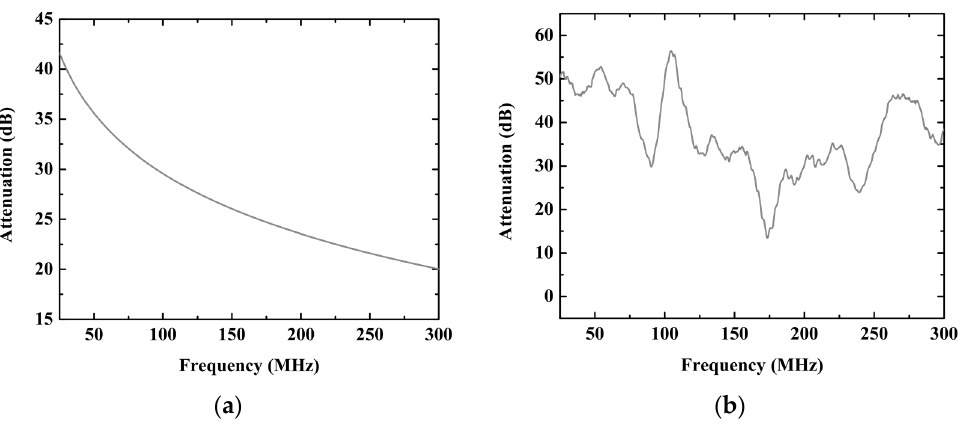
Figure 10. ( a ) Estimated attenuation of the Faraday cage calculated by Equation (5); ( b ) Measured attenuation of the Faraday cage, characterized with the 0.3 m-dipole antenna placed inside the cage.